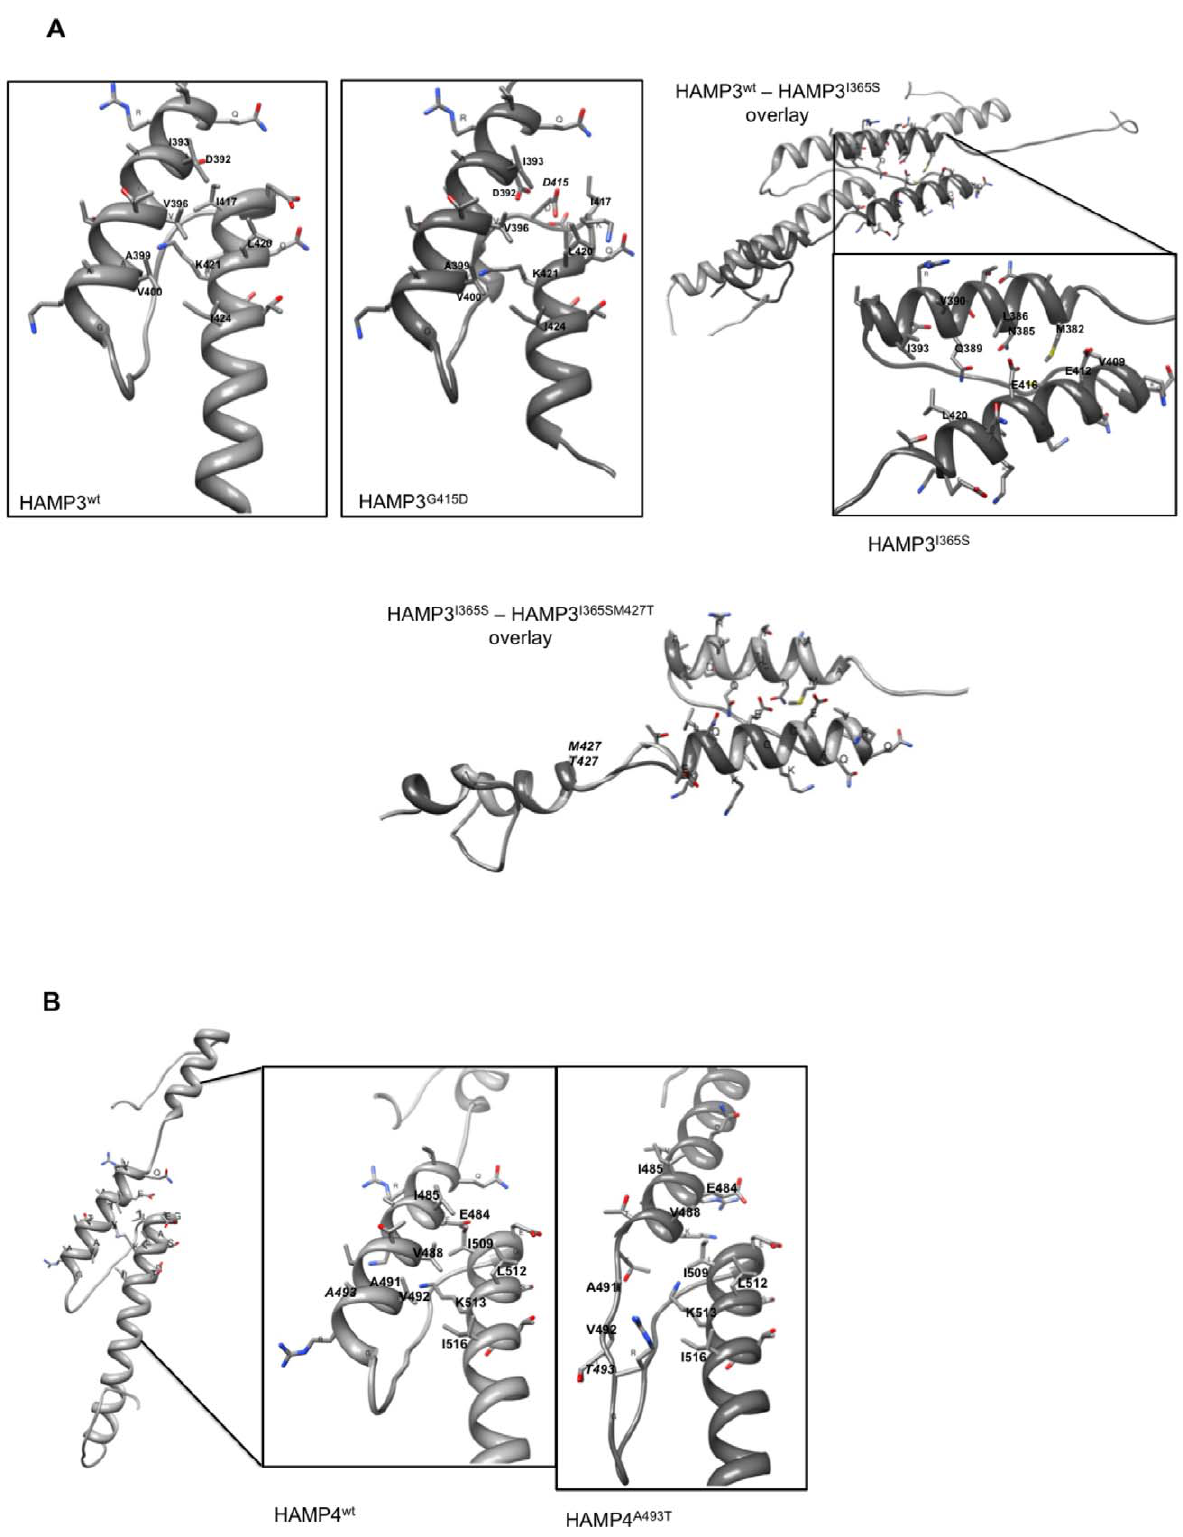
Figure 3. Homology based models of HAMP domains with focus on interactions between AS1 and AS2. A/ HAMP3 wt and mutant peptides. In the last panel I365S (light grey) and I365S M427T (dark grey) isoforms are shown in an overlay. B/ HAMP4 wt and mutant peptides. The orientation of the peptides is from up (N-terminus) to down (C-terminus) or from right to left (A). Solely, the side chains from amino-acids of the connector proximal helices are displayed. Residues potentially involved in interactions are labelled; modified residues are written in italics. In overlaid models, the wild-type peptide is shaded in light grey, the mutant peptide in dark grey.